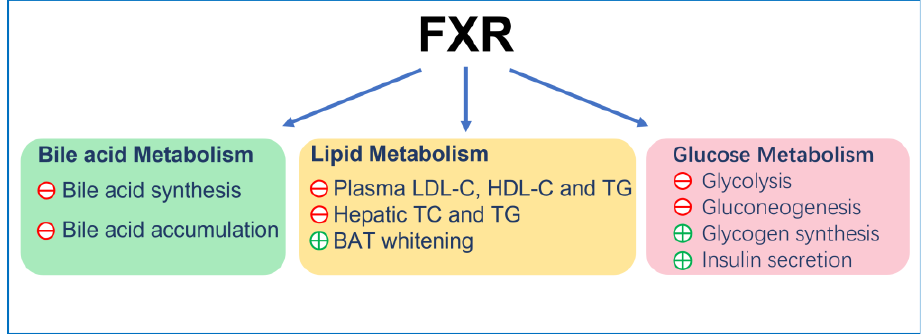
Figure 1. The general function of FXR. ㊉ indicates stimulation; ㊀ indicates